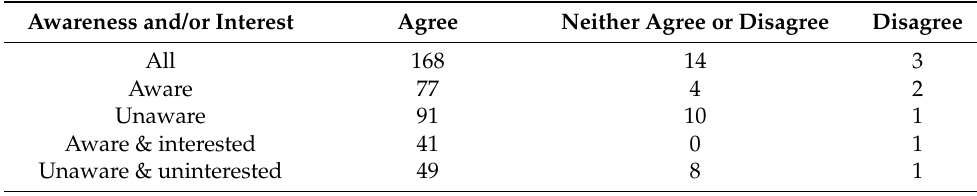
Table 4. Belief that climate change is a real event.